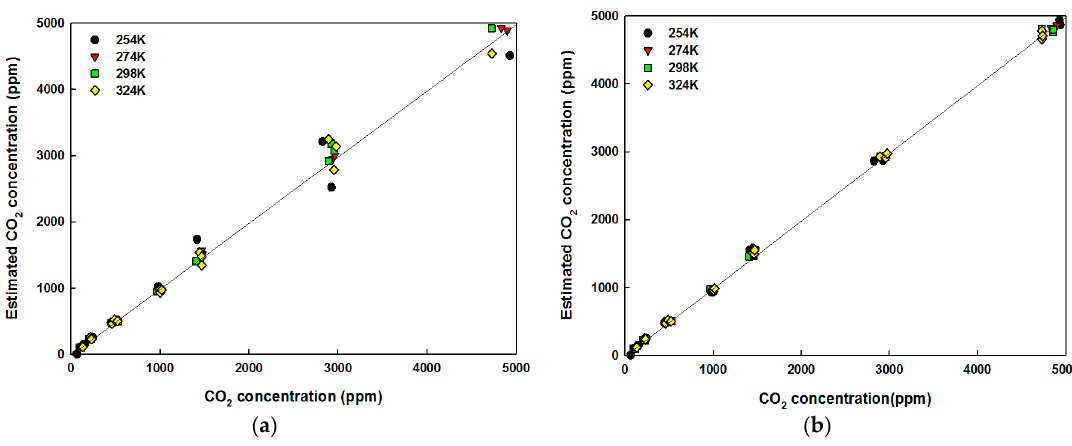
Figure 4. Estimated CO 2 concentrations after adopting temperature compensation algorithm: ( a ) with normal structure; ( b ) with reflectors deposited a hydrophobic thin